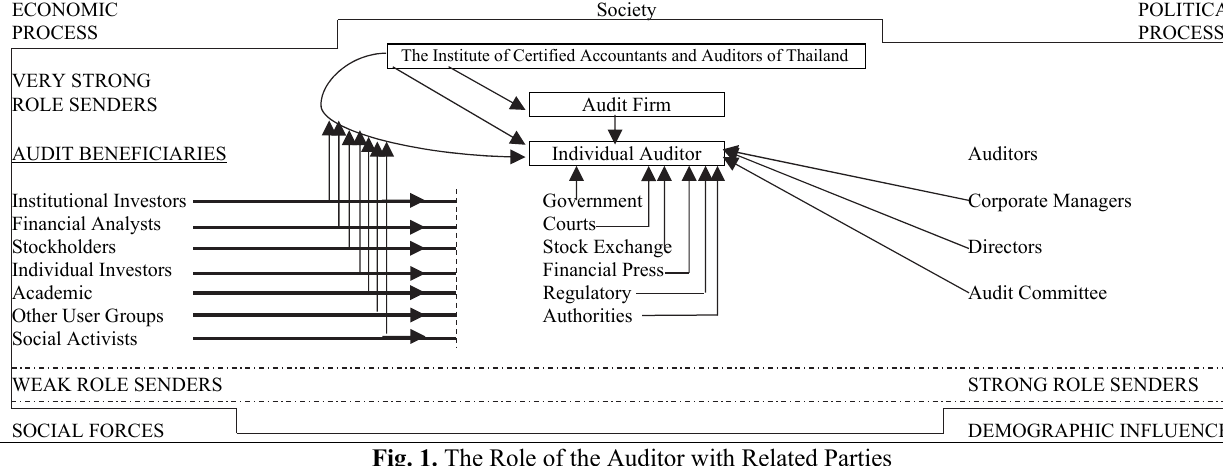
Fig. 1. The Role of the Auditor with Related Parties (Source: Onulaka & Samy